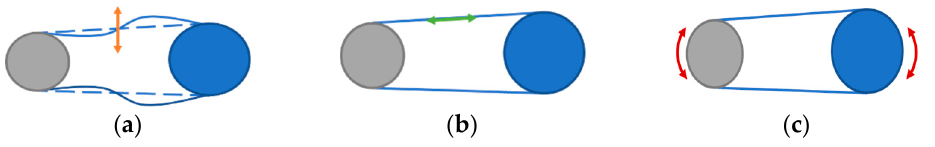
Figure 2. Vibration types of a belt transmission system: ( a ) transverse vibration, ( b ) longitudinal vibration, ( c ) rotational vibration.